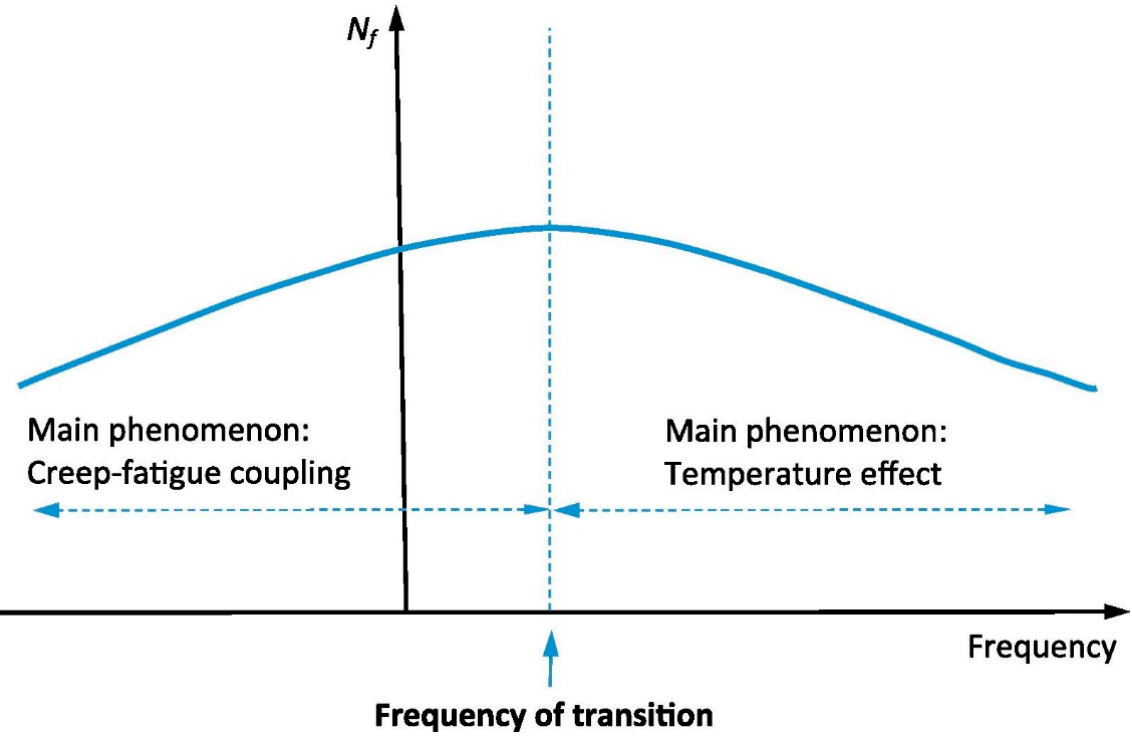
Figure 27. The schematic representation of the frequency transition effect on of critical self-heating temperature induced by failure modes, adapted with permission from Ref. [64]. Copyright © 2020 Elsevier